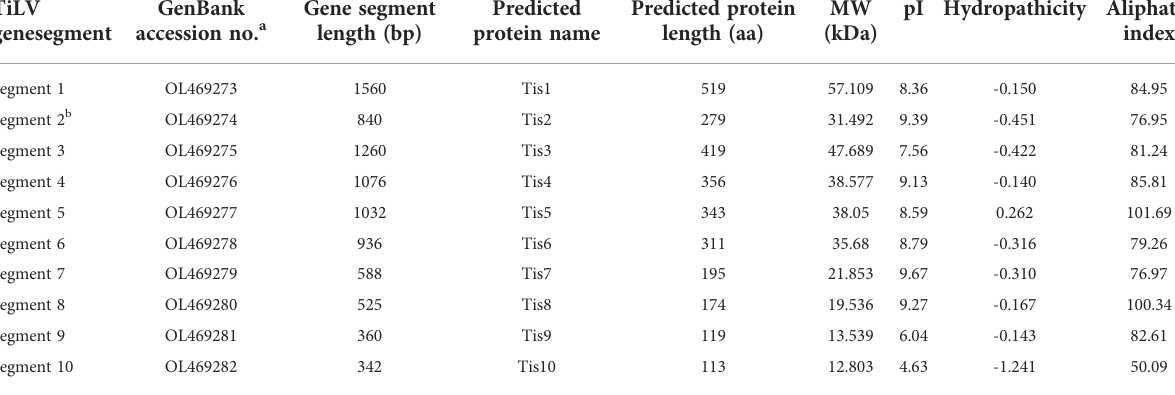
TABLE 1 ORF-encoded protein prediction and biochemical properties of TiLV segments 1-10 (Tis1 - Tis10) proteins. TiLV